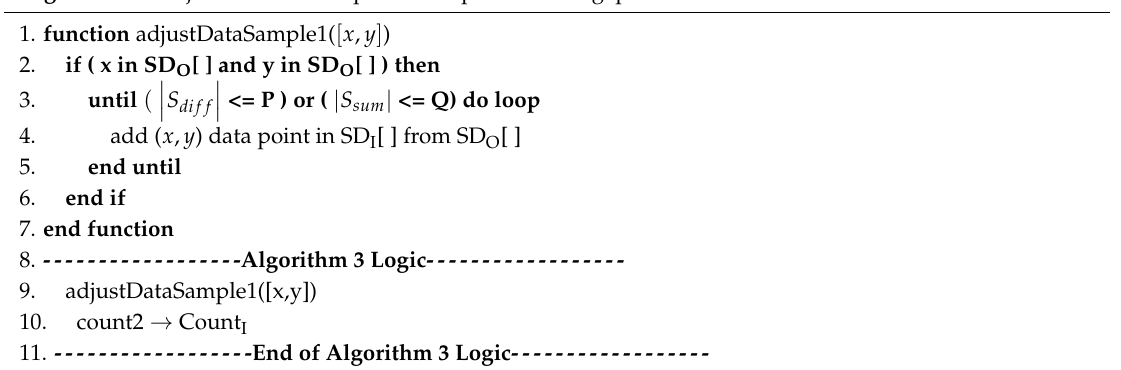
Algorithm 3. Adjustment of data points sample based on gap difference and summation